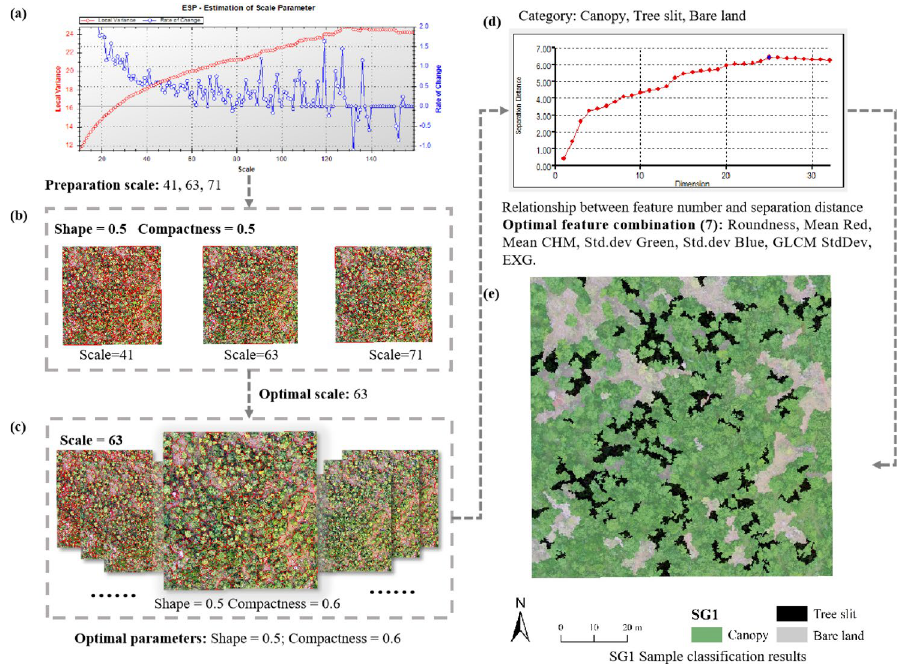
Figure A3. The process of extracting the canopy of sample SG1 based on object-oriented method. ( a ) The preparation scales were calculated using the ESP2 tool and obtained as 41, 63, 71; ( b ) The shape and compactness parameters were both set to 0.5 for comparison to obtain the optimal segmentation scale of 63; ( c ) The shape and compactness parameters are 0.5/0.6 when iterating through the shape and compactness parameters to obtain the best segmentation effect, respectively; ( d ) According to the relationship between feature number and separation distance choose to the optimal feature combination; ( e ) SG1 sample classification results.